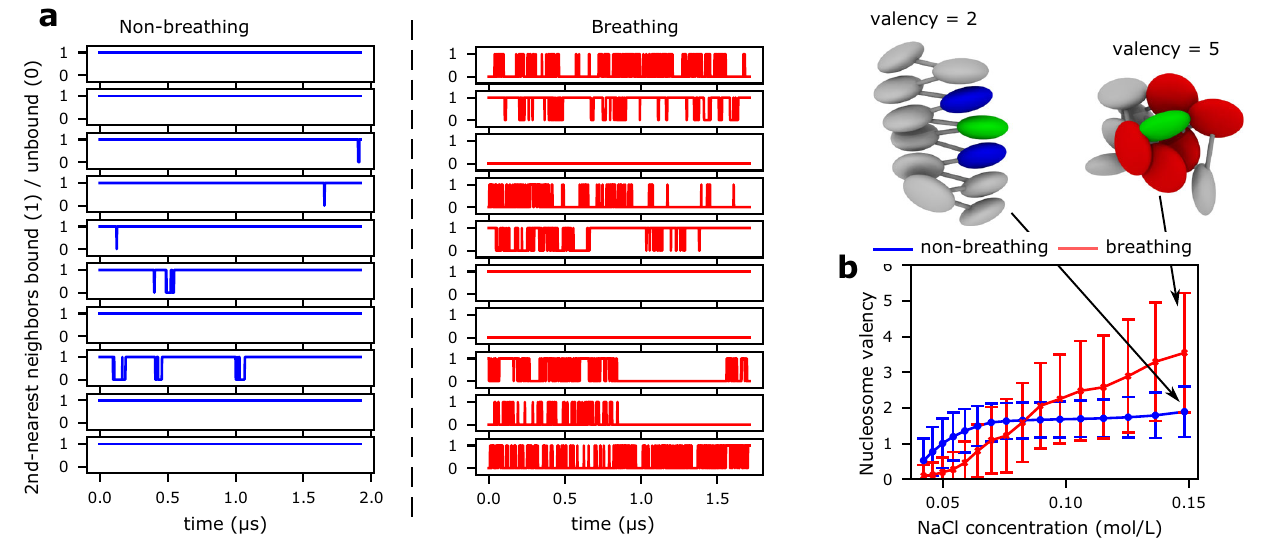
Fig. 5 Dynamic nature of nucleosome – nucleosome interactions within compact chromatin. a Time series of the binding (1) and unbinding (0) of second- nearest nucleosome neighbor pairs computed from ten independent unbiased MD trajectories at 0.10 mol/L NaCl. The binding/unbinding behavior of non- breathing (left; blue) versus breathing (right; red) nucleosomes is summarized. b Average valency of a non-breathing (blue) versus a breathing (red) nucleosome — de fi ned as the average number of nucleosome neighbors that each nucleosome “ contacts ” simultaneously (i.e., within a center-to-center distance of 110 Å ; see Supplementary Methods) — within compact chromatin versus NaCl concentration. The spread of the data around the mean values, mean ± s.d., are shown as bands; these were obtained by comparing n = 500 independent con fi gurations. The cartoon at the top-left highlights a non- breathing reference nucleosome (green) with a valency of two (i.e., in simultaneous contact with the two blue nucleosomes). The cartoon at the top-right illustrates a breathing nucleosome (green) that is in simultaneous contact with fi ve other nucleosome neighbors